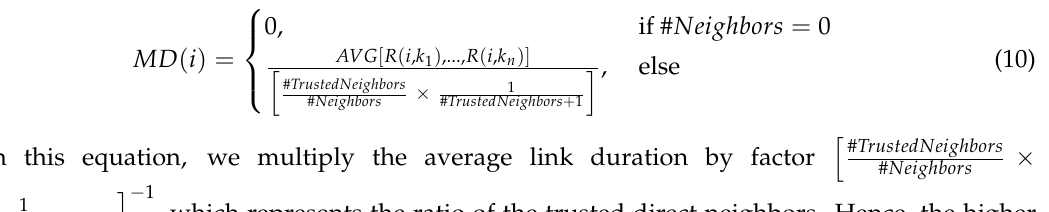
Figure 6. Hello messages